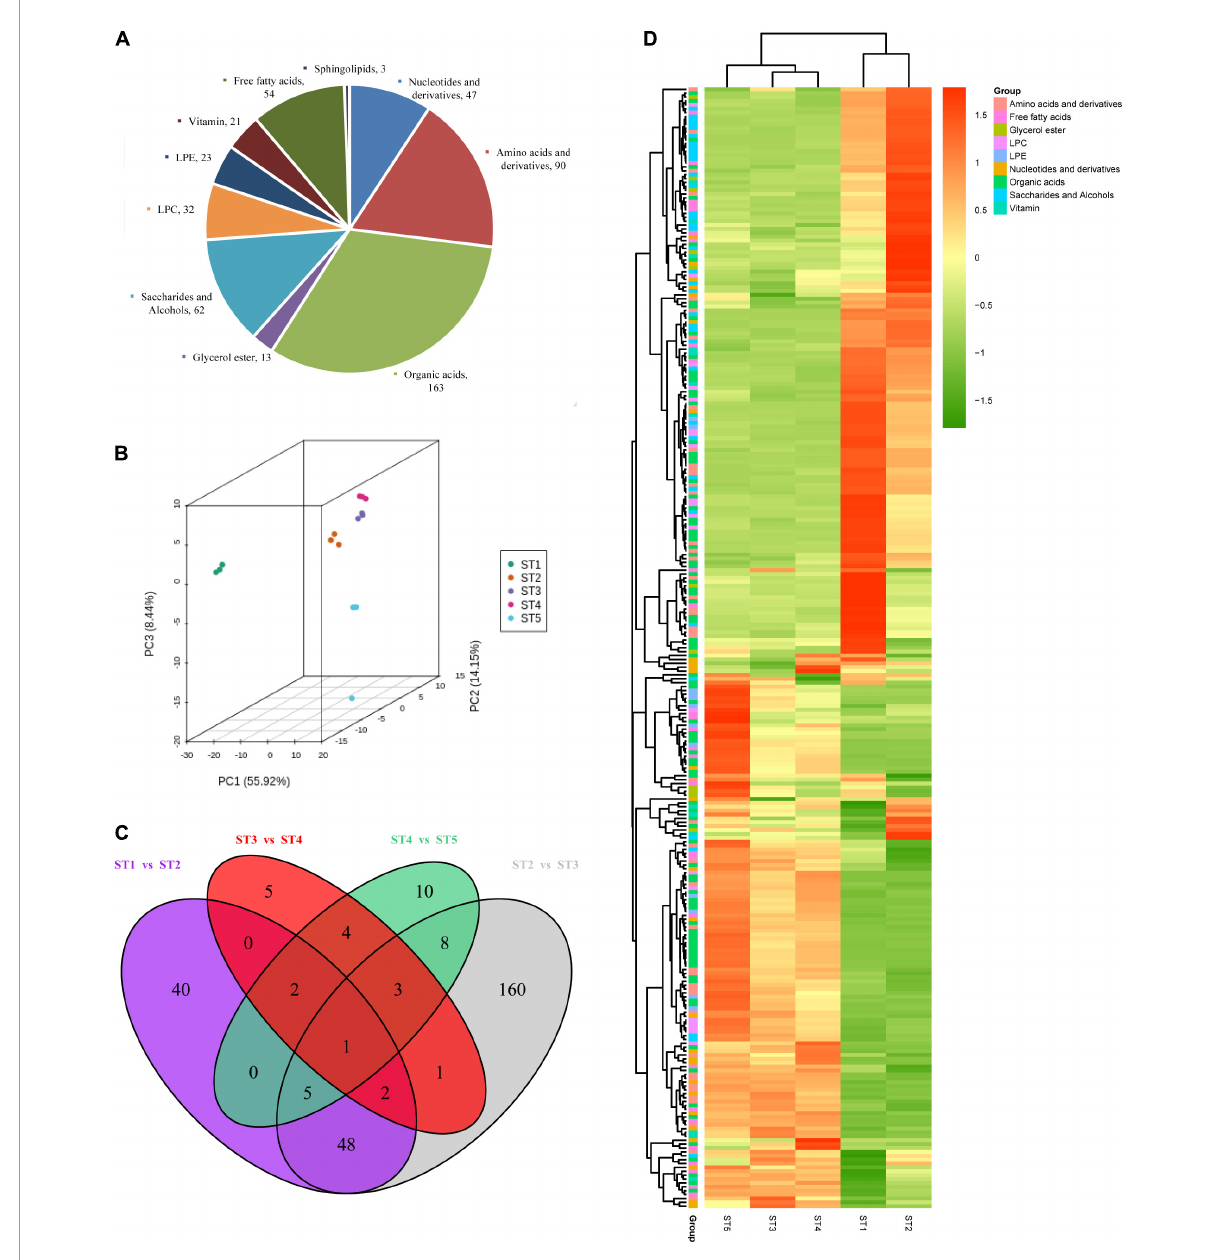
FIGURE2 The metabolomics data of the jujube fruit at different stages. (A) Pie chart of primary metabolites identified in jujube fruits. (B) PCA analysis of the jujube fruit samples. (C) Venn diagram showing the differential accumulated metabolites (DAMs) of comparison groups. (D) Heatmap of 228 differentially accumulated metabolites (DAMs). Different colors in the heat map represent the values obtained by normalizing the relative content of differential metabolites, reflecting their relative content (the color bar from green to red represents low content to high content), and the annotation bar on the right side of the clustering tree corresponds to the secondary substance of Class